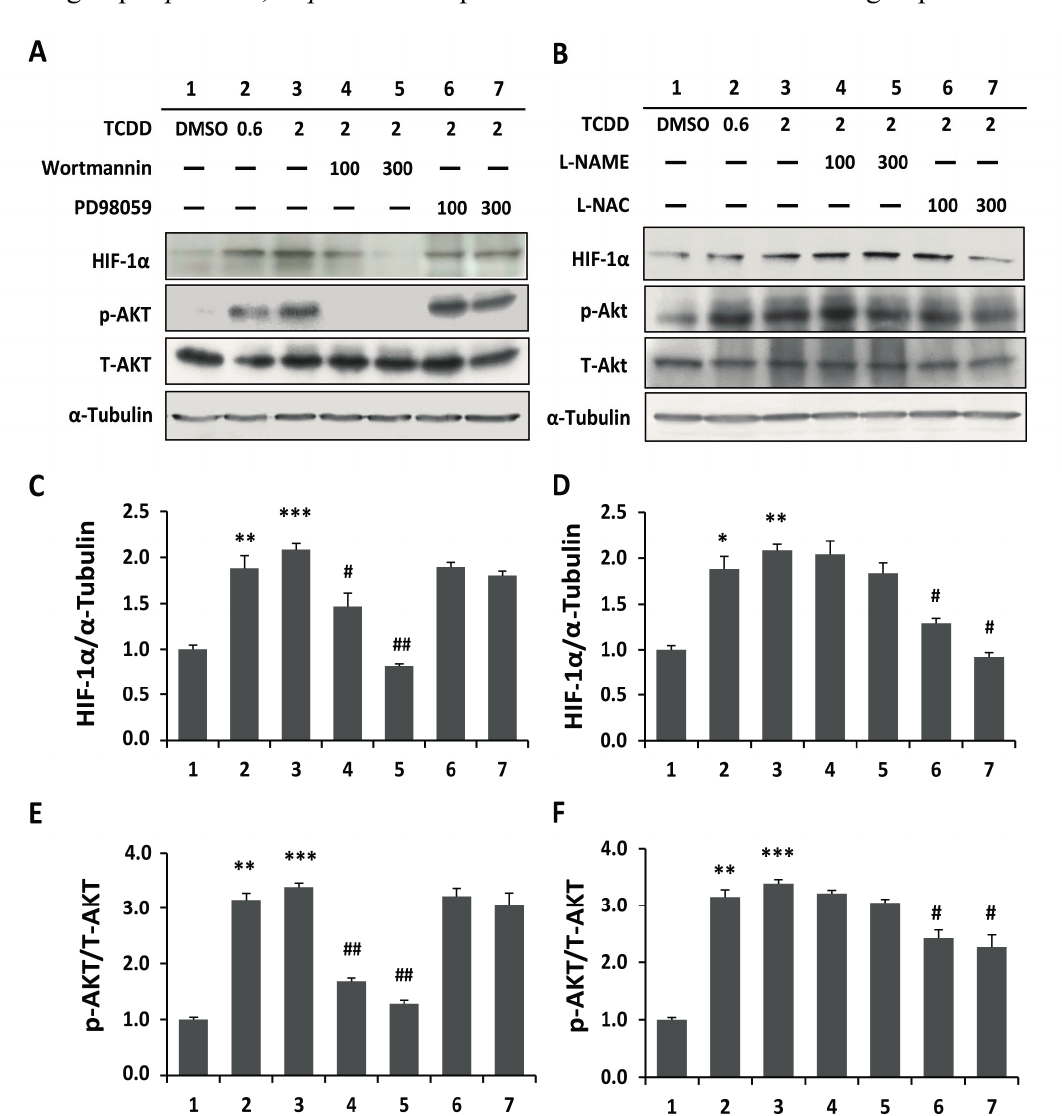
Figure 3. ROS signaling and phosphoinositide-3-kinase (PI3K) pathway are involved in TCDD-induced HIF-1 α stabilization and Akt phosphorylation. ( A ) Cells were pre-treated with wortmannin (PI3K inhibitor) or PD98059 (2'-amino-3'-methoxyflavone, the mitogen-activated protein kinase kinase (MEK) inhibitor) for 30 min and then incubated with 2 nM TCDD for 1 h; ( B ) Cells were pre-treated with N -acetylcysteine (NAC, ROS scavenger) or N ω -nitro- L -arginine methyl ester hydrochloride (NAME, NO scavenger) for 30 min and then incubated with 2 nM TCDD for 1 h. The protein levels of HIF-1 α , phospho-Akt (p-Akt), and total Akt (T-Akt) were immunodetected by western blotting; ( C – F ) The mean densitometry data from independent experiments were normalized to the results obtained for cells in the absence of TCDD (as control group). The plots are presented as the mean ± SD ( n = 3). * p < 0.05; ** p < 0.01; *** p < 0.001 compared with the control group. # p < 0.05; ## p < 0.01 compared with the 2 nM TCDD-treated